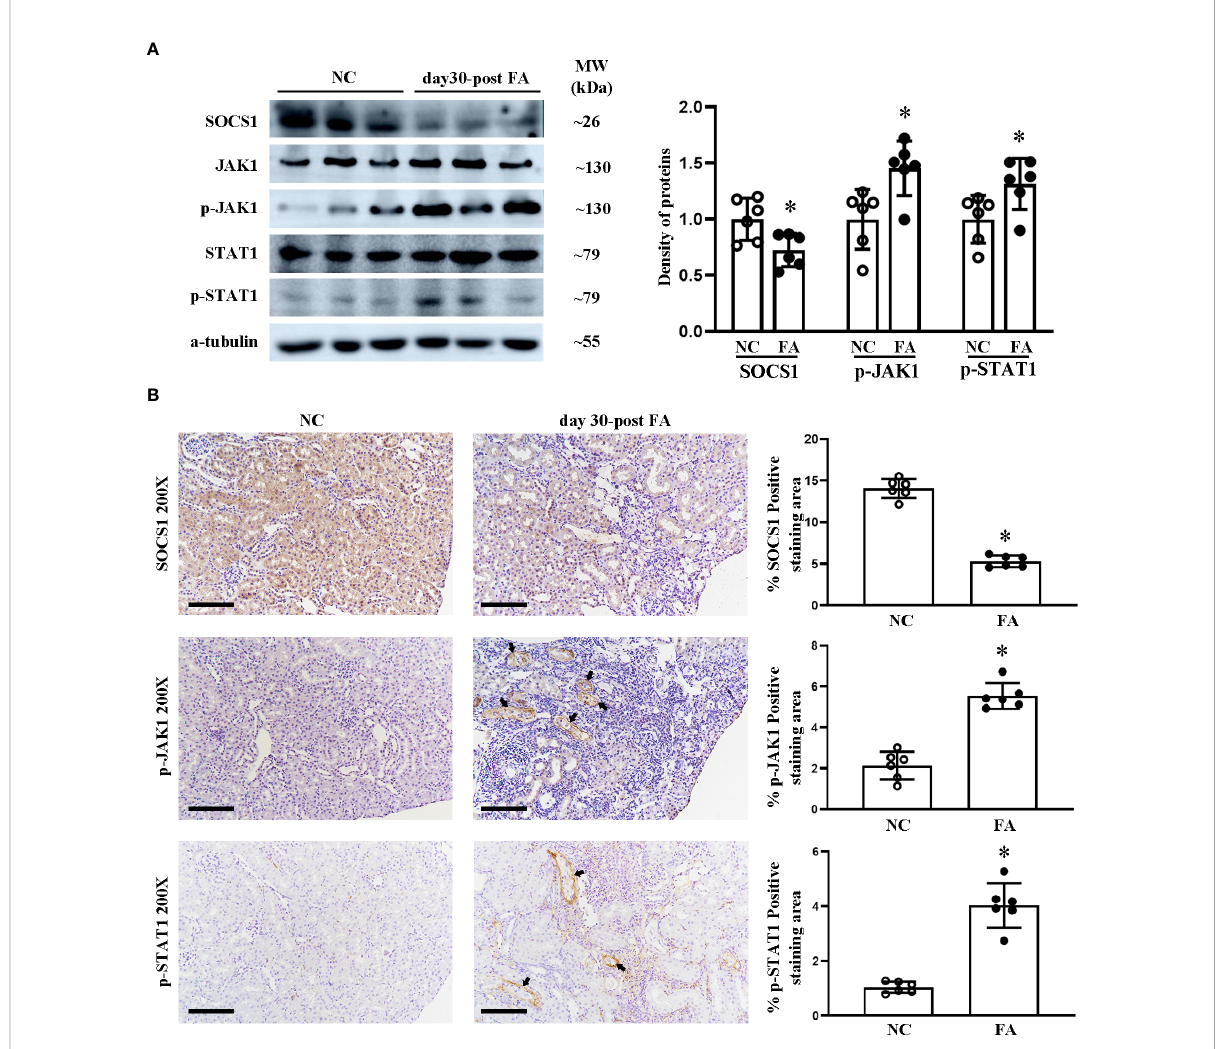
FIGURE 3 Renal expression of proteins on the SOCS1/JAK1/STAT1 pathway in folic acid (FA)-induced renal interstitial fi brosis mice. Western blotting (A) of SOCS1, JAK1, p-JAK1, STAT1, and p-STAT1 and the density of the blots. Immunohistochemical (IHC) staining (B) of SOCS1, p-JAK1, and p-STAT1 and the percentage of positive-staining area of each of the abovementioned proteins. For IHC, magni fi cation = ×200, scale bar = 100 m m. For all graphs, data are presented as mean ± SD, n = 6. * p < 0.05, day 30 post-FA group vs. NC